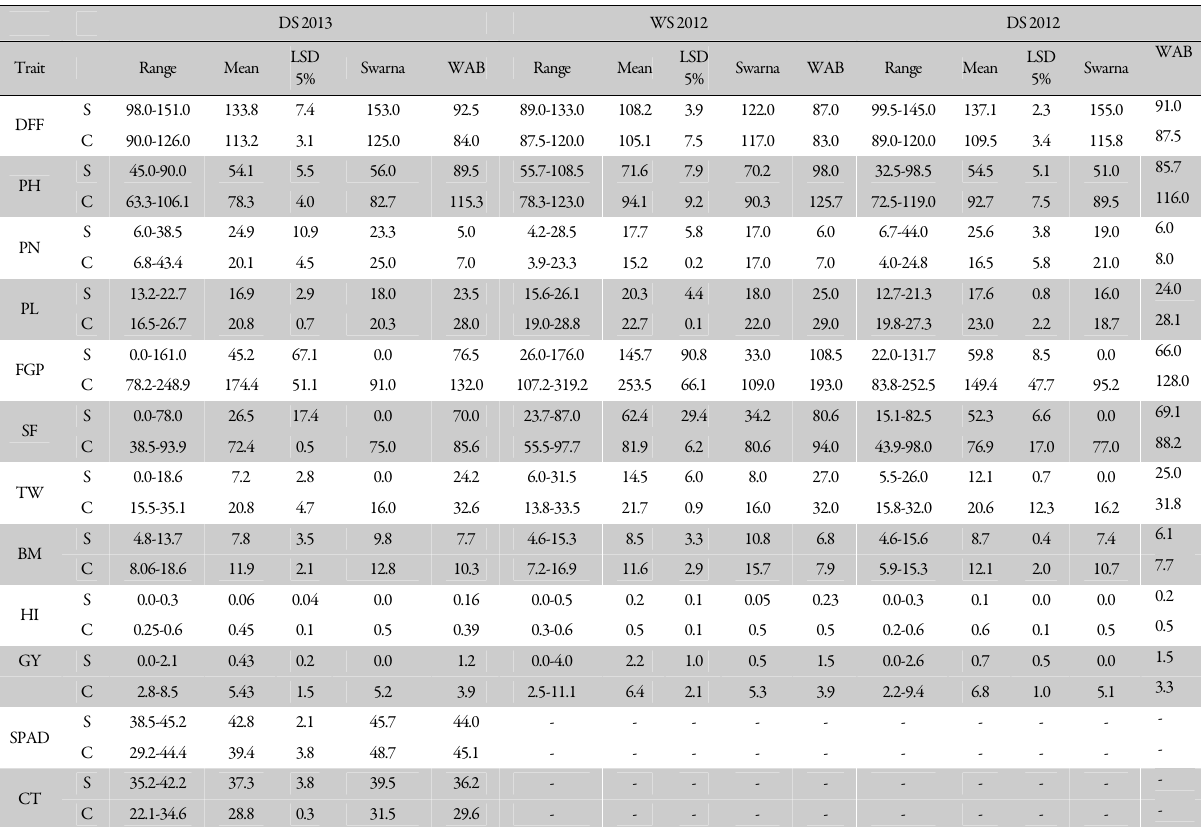
Tab. 1. Range, mean and LSD 5% of the Swarna/WAB450-I-B-P-157-2-1 population and parents under reproductive stage stress (S) and control (C) conditions in DS 2013, WS 2012 and DS